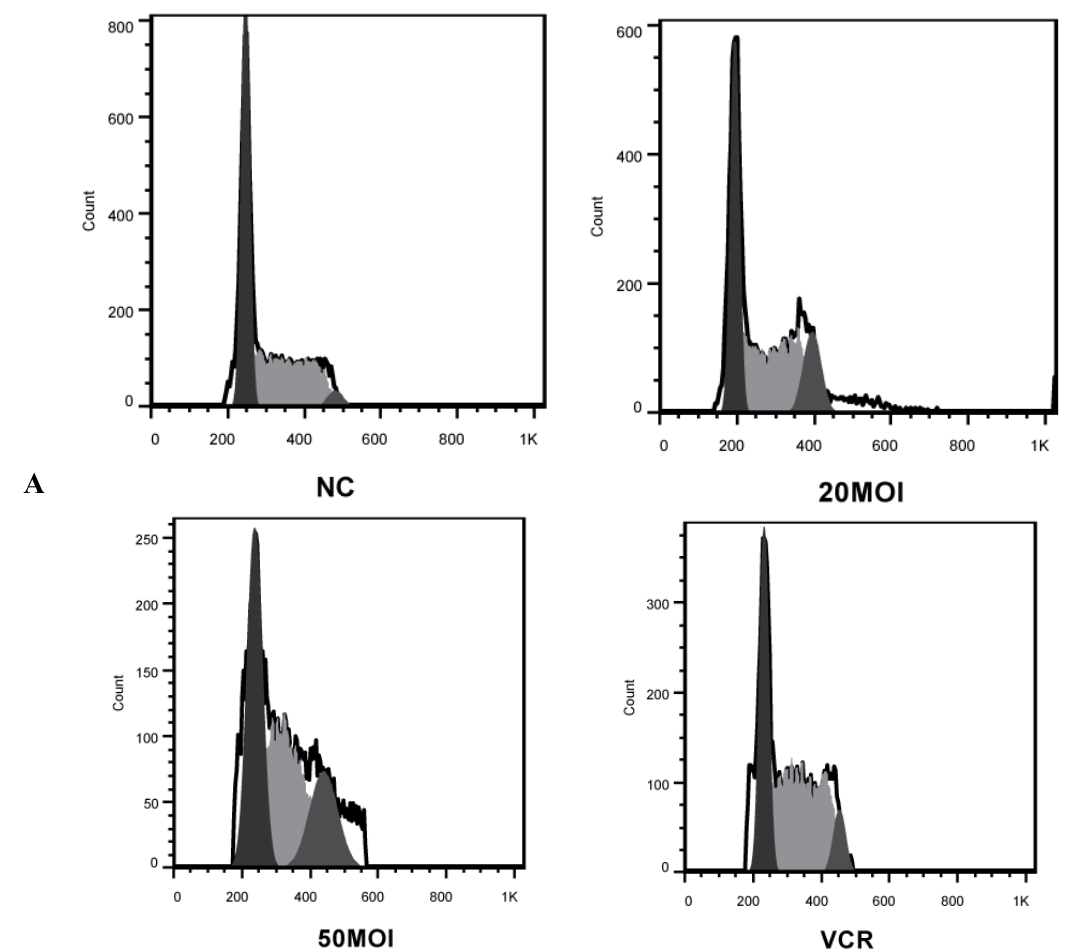
Figure 3. Representative FACS histograms showing the cell cycle distribution in HXO-RB cells following different treatments. ( A ) Cell cycle analysis was performed by 44 quantifying propidium iodide (PI) incorporation by flow cytometry. DNA content and number of events were analyzed after different treatments for 48 h; ( B ) relative changes in the percentage in each cell cycle phase were plotted after PI staining and FACS analysis. Results are representative of three independent experiments (** p < 0.01, compared with S /M phases of HXO-RB treated with 5 nM VCR). NC (negative control): treatment and G 2 44 with